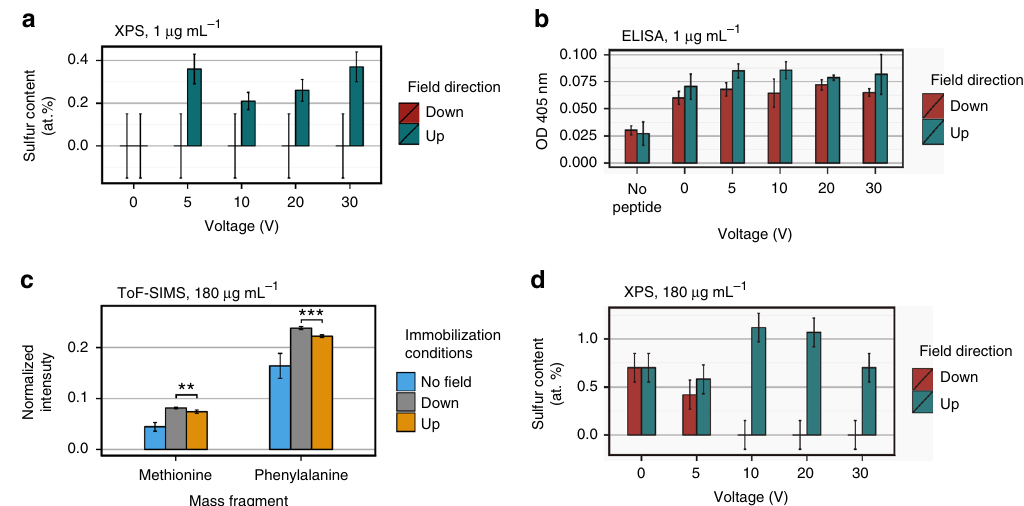
Fig. 5 External fi eld controls peptide density and orientation. a The sulfur atomic concentration of the peptide-functionalized surface from X-ray photoelectron spectroscopy (XPS) as a function of applied voltage (peptide solution concentration = 1 µ g mL − 1 ). An increase in peptide arrival rate is observed for the E up fi eld, while no peptide is detectable for the E down fi eld. b The absorbance measured with enzyme-linked immunosorbent assay (ELISA) as a function of applied voltage showing that peptide is present after immobilization in both E up and E down fi eld directions (peptide solution concentration = 1 µ g mL − 1 ). c Time of fl ight secondary ion mass spectrometry (ToF-SIMS) normalized mass fragments of the hydrophobic peptide residues indicate approximately equal amounts of FLAG DOWN peptide (peptide solution concentration = 180 µ g mL − 1 ). d The sulfur atomic concentration of the peptide- functionalized surface from XPS as a function of applied voltage (peptide solution concentration = 180 µ g mL − 1 ). Surface peptide is increased by E up , and decreased by E down relative to the case when no fi eld is applied. Given the higher concentration for the E up fi eld but equal amount of hydrophobic residues (indicating FLAG DOWN peptide) in ToF-SIMS, there is a higher proportion of FLAG UP peptide for this fi eld direction compared to the E down direction. Error bars are s.d. and P -values are from the Student ’ s two-tailed t -test: ** P < 0.01, *** P < 0.001 ( b , c ). XPS error bars are calculated from the background